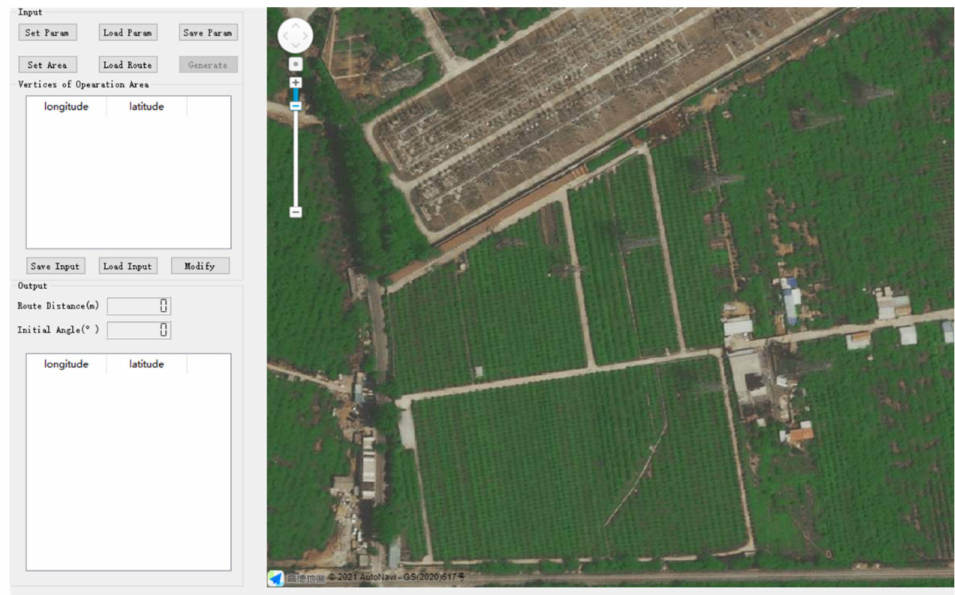
Figure 5. The user interface of the route-planning simulation software. Users can set the operation region by clicking on the map or by sequentially inputting geographical coordinates.